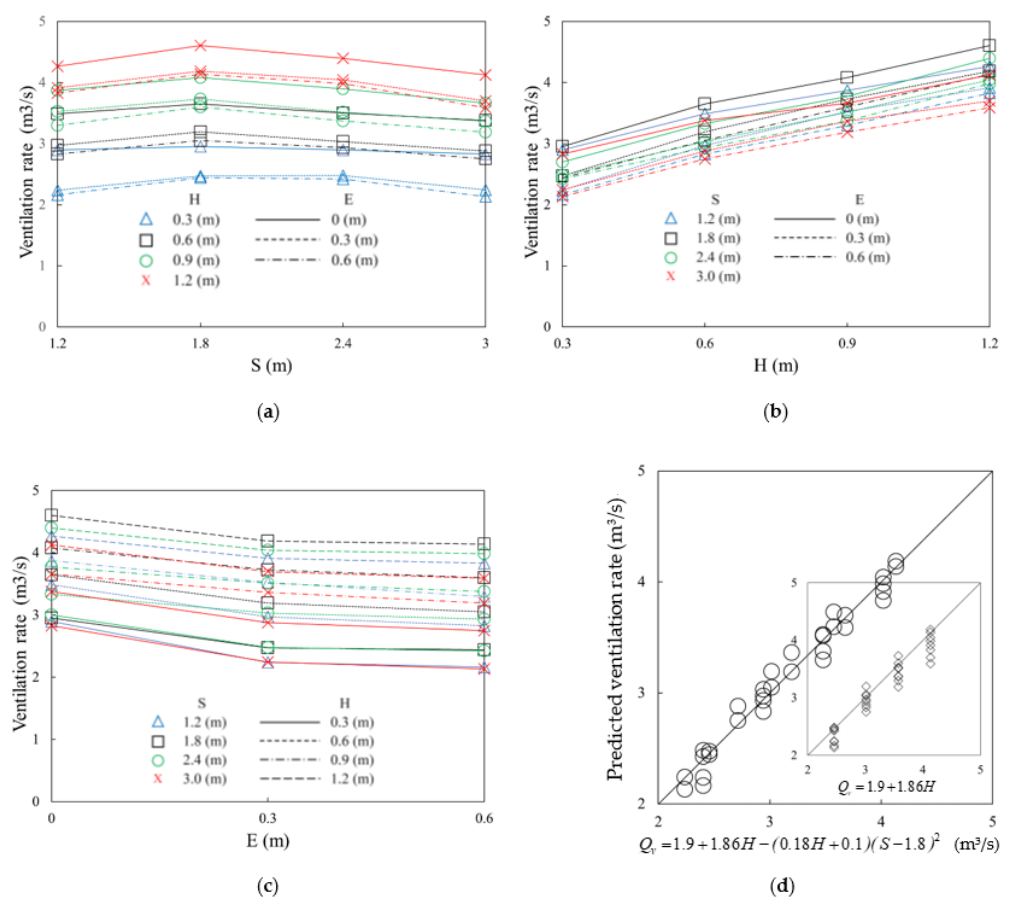
Figure 6. Effect of design parameters on the ventilation rate and their relationship. ( a ) Effect of design parameter S; ( b ) Effect of design parameter H; ( c ) Effect of design parameter E; ( d ) Correlation.